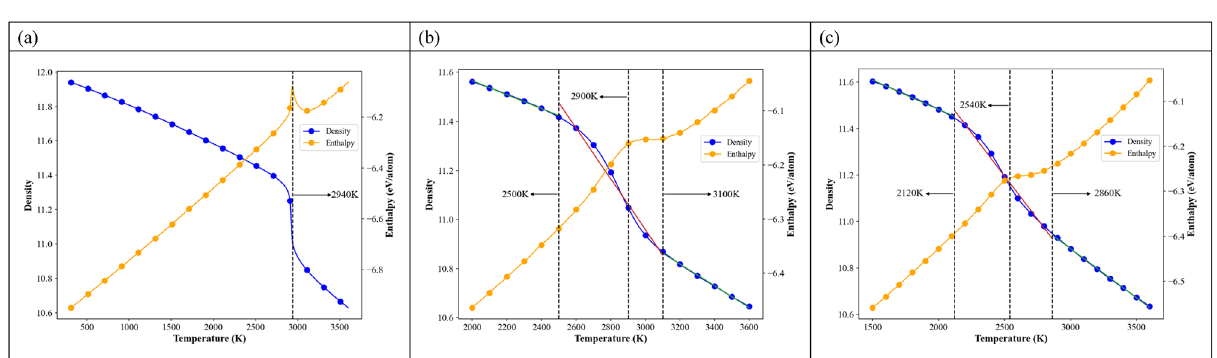
Figure 4. Density and enthalpy profiles of Nb 20.6 Mo 21.7 Ta 15.6 W 21.1 V 21.0 RHEAs during the heating process for ( a ) single crystal, ( b ) 25.3 nm, and ( c ) 5.2 nm. The melting points of single crystal, 25.3 nm, and 5.2 nm are 2940, 2900, and 2540 K as indicated by the dashed lines. The temperatures at discontinuities of density profiles of two polycrystalline RHEAs are also indicated by the dashed